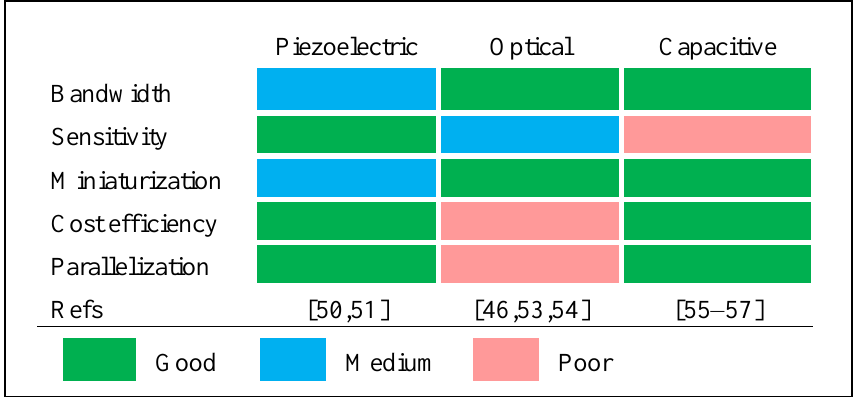
Table 1. Comparison of different sound detection technologies used in optoacoustic